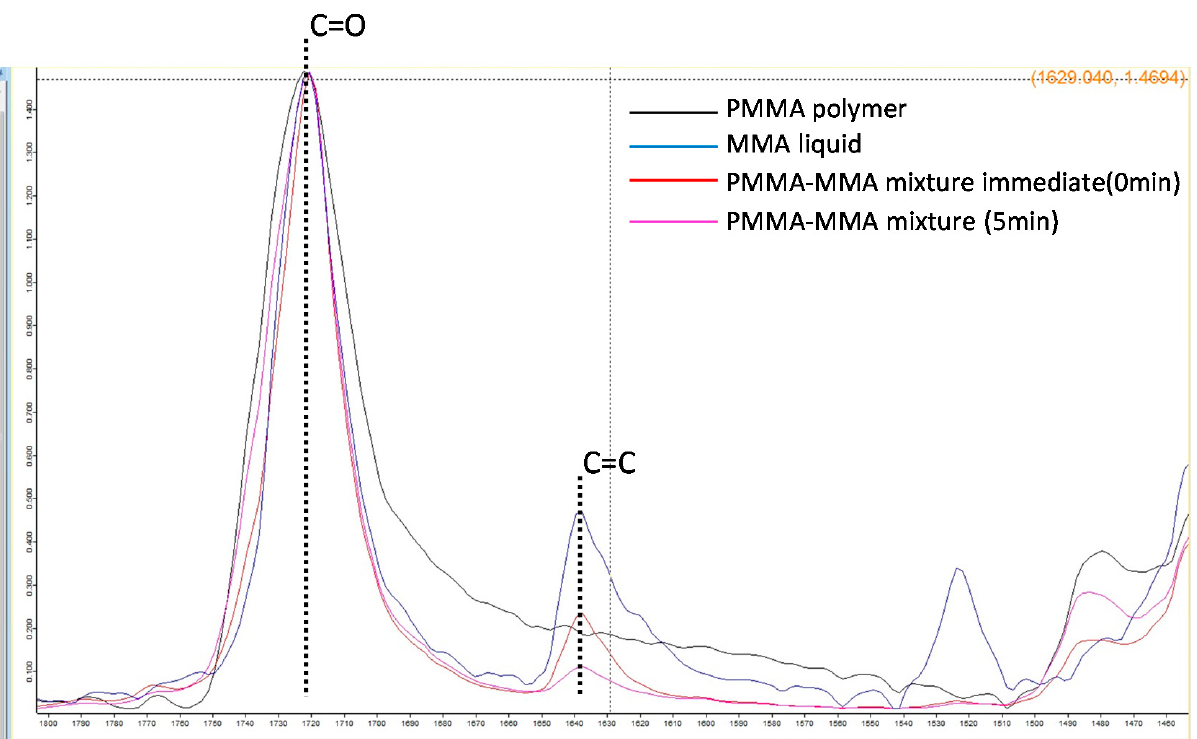
Figure 9. FTIR spectra of the absorption peaks of the vinyl group (C=C) and the carbonyl group (C=O) of each sample. Table 3. Degree of Conversion (%).